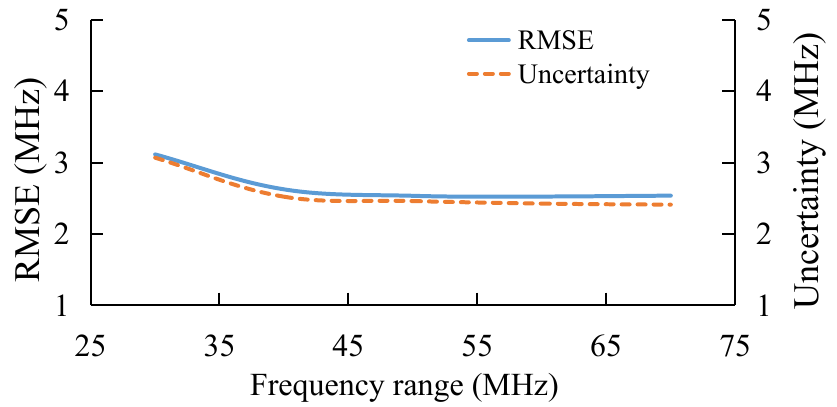
Figure 5. BFS extraction under different frequency range.